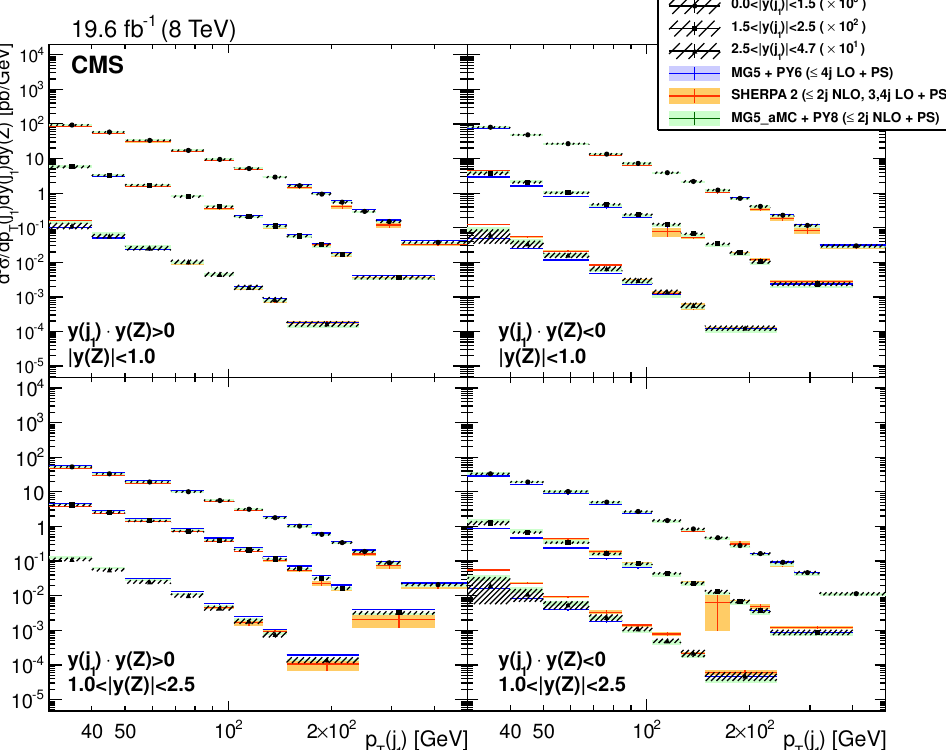
Figure 37 . The di(cid:11)erential cross section for Z ( ! ‘‘ ) + jets production as a function of the rapidities of the Z boson and leading jet, and of the transverse momentum of the jet for the con(cid:12)guration. The bottom plots correspond to the con(cid:12)guration where the boson and the jet are in di(cid:11)erent hemispheres ( y (Z) y (j ) < 0), while the top plots correspond to both objects in the 1 same hemisphere. The left and right plots show the respective Z boson rapidity ranges, j y (Z) j < 1 and j y (Z) j 2 (1 ; 2 : 5). The bands around the measurement points represent the total measurement uncertainties. The bands around the prediction points represent the total uncertainty, statistical, theoretical, and PDF components for mg5 a mc + pythia 8, and the statistical uncertainty alone for MadGraph 5 + pythia 6 and sherpa